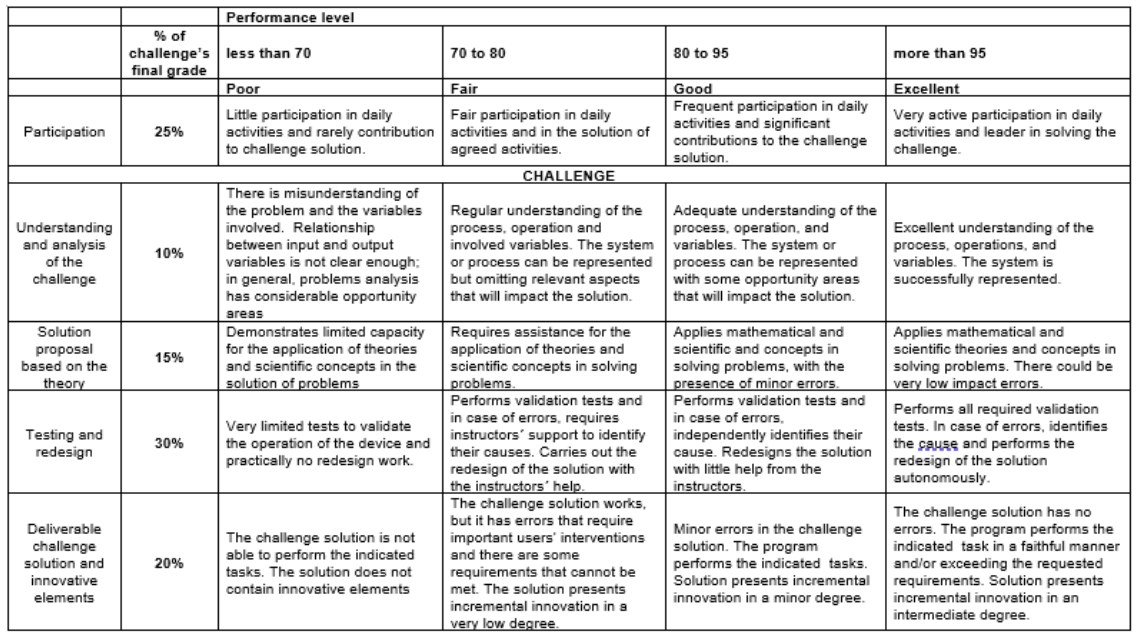
Figure A1. Evaluation rubric for the drones rally challenge activity.